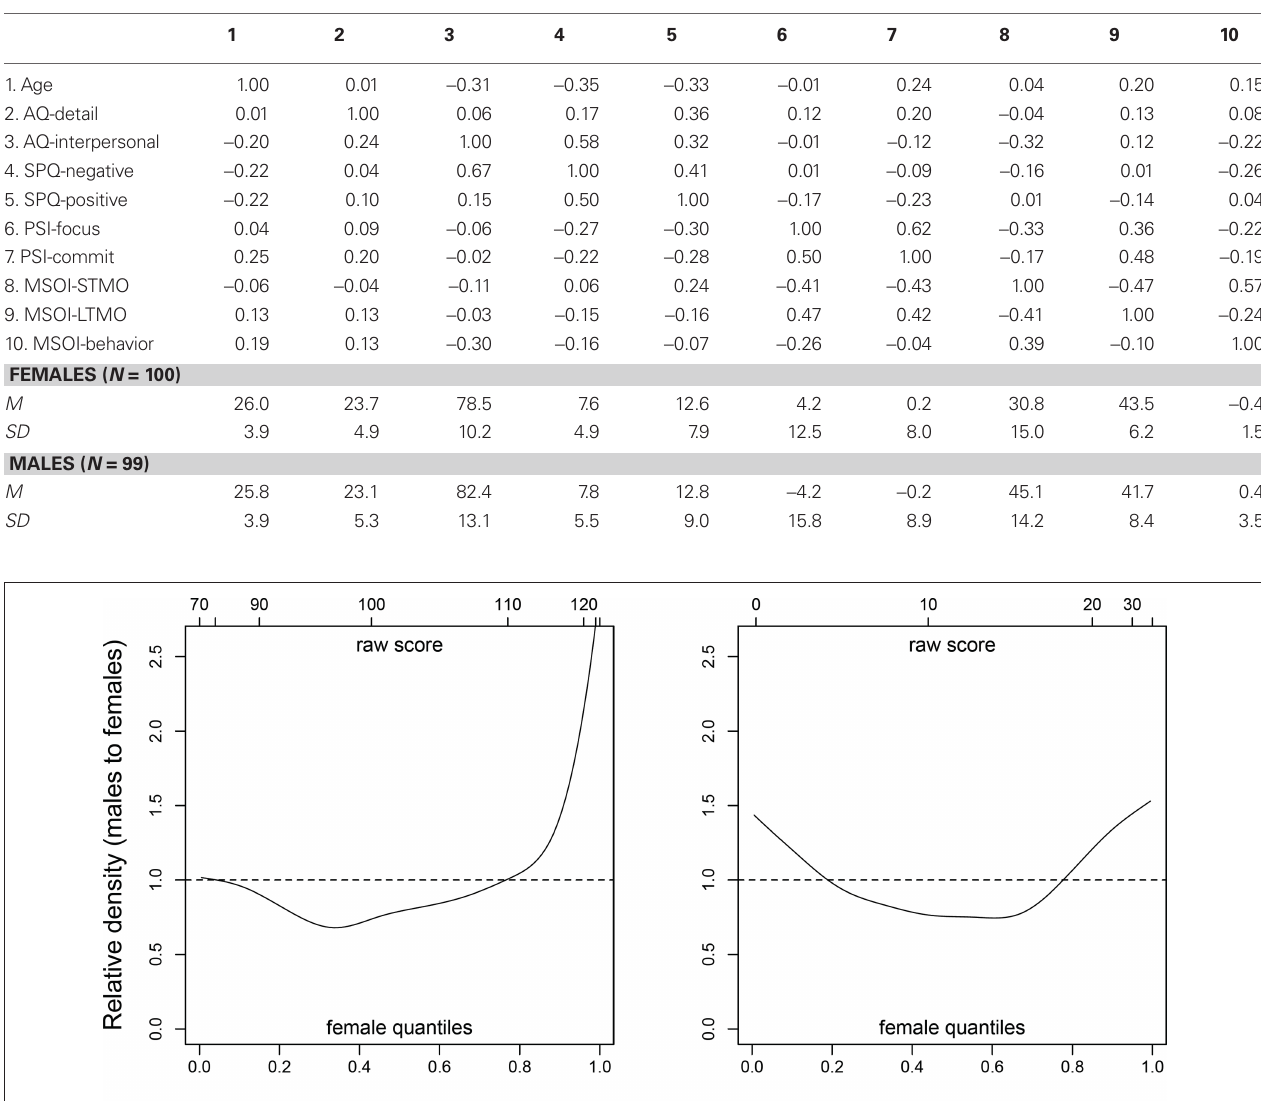
Table 1 | Zero-order correlation matrix, means, and standard deviations of the study variables (untransformed scores). Correlations in the male subsample are shown below the diagonal, those in the female subsample above the diagonal.